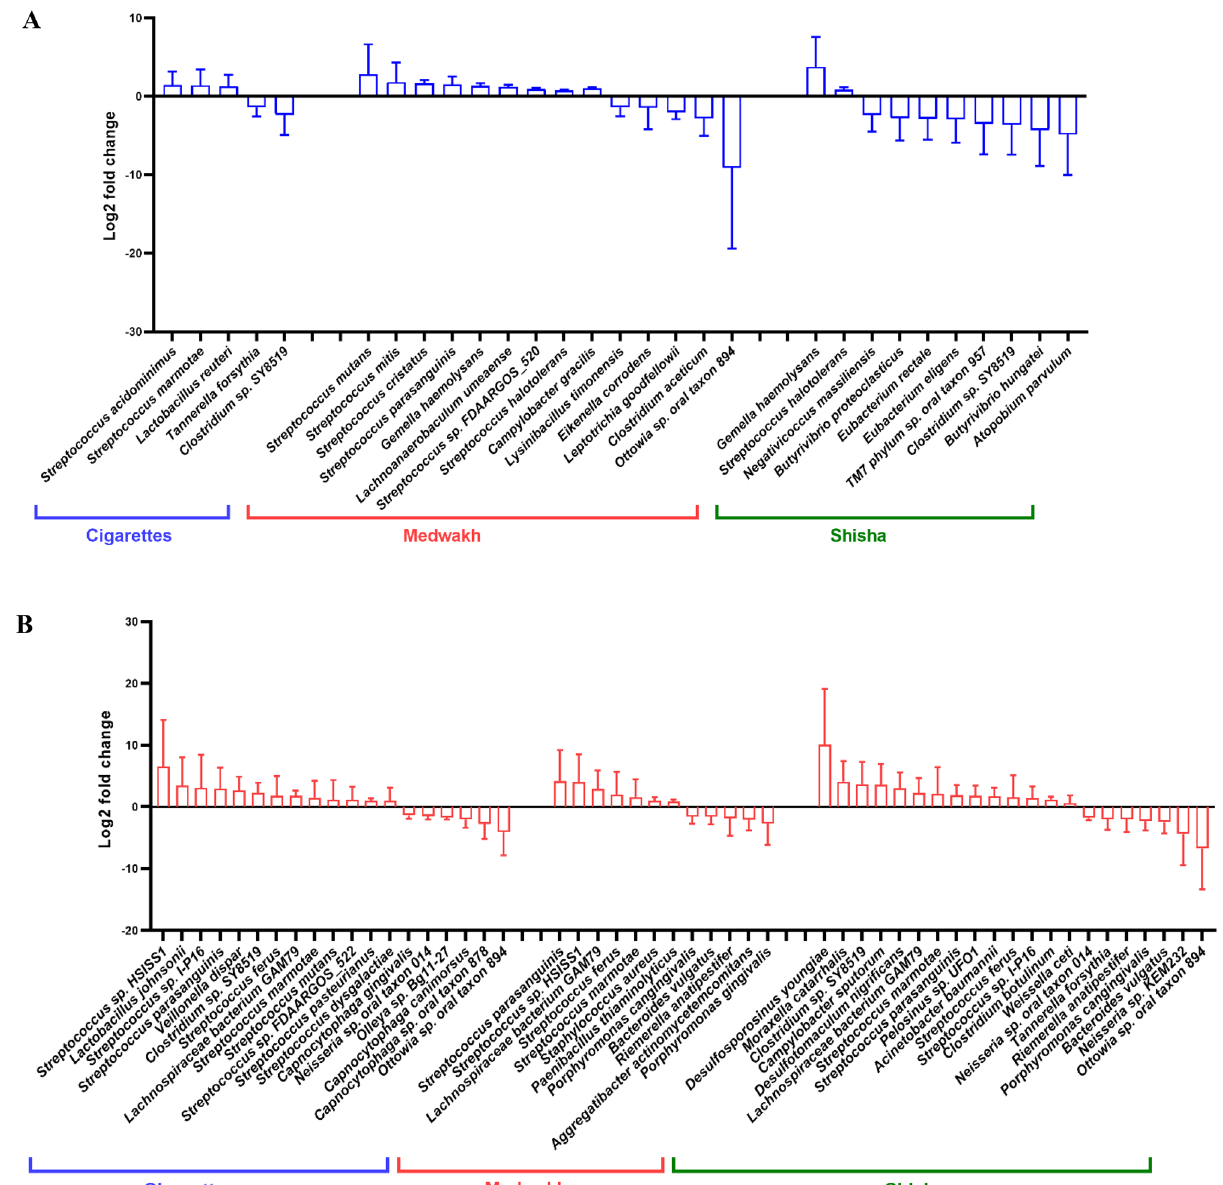
Figure 5. Species significantly altered in smokers of different tobacco types. Data represent Log2 folds change of the relative abundance of each species in smokers compared to non-smokers ( A ) in no-low caries group ( B ) in moderate-high caries